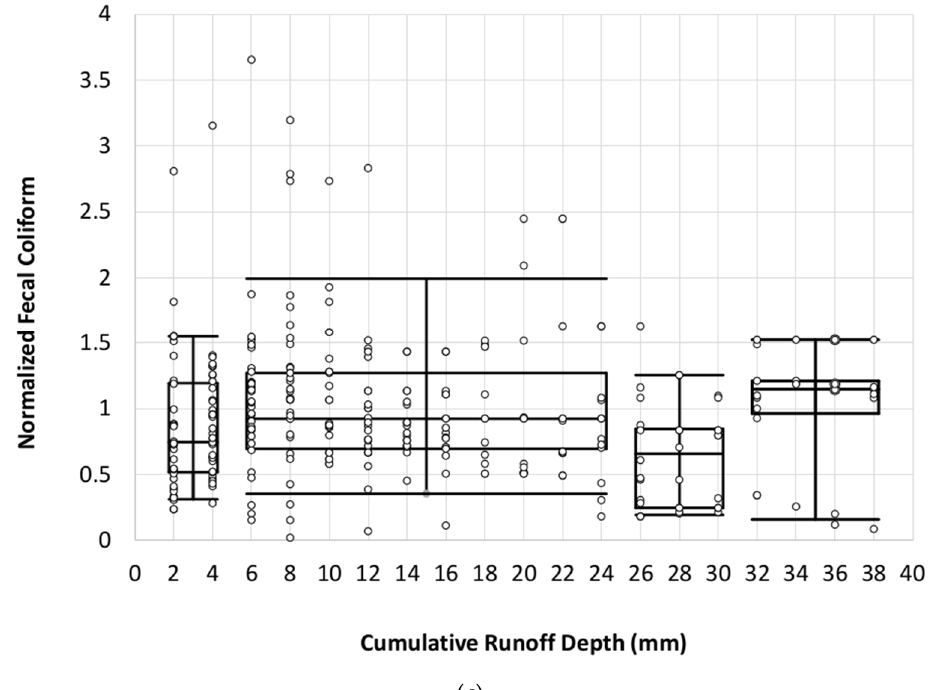
Figure 3. Bach method using ( a ) 1 mm slice size, ( b ) 2 mm slice size, and ( c ) combined data from 1 mm slices into 2 mm slice size intervals for fecal coliform at Second Creek.